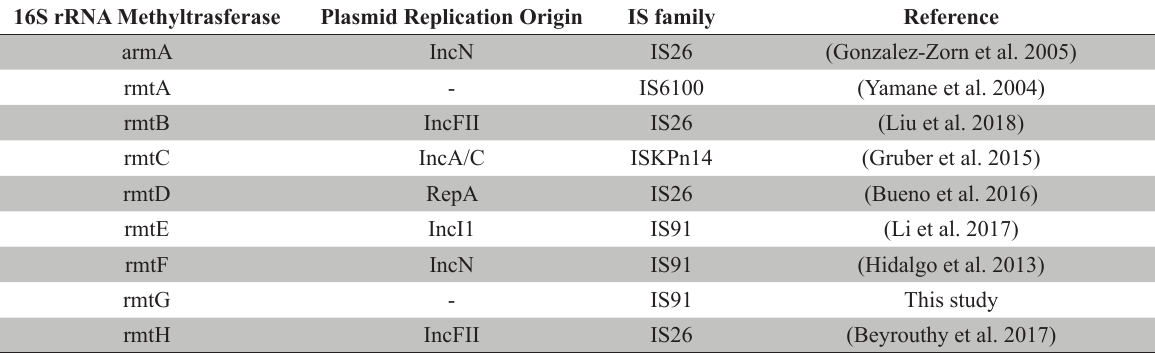
Comparison between acquired 16S methyltransferases location based on previous studies. 16S rRNA Methyltrasferase